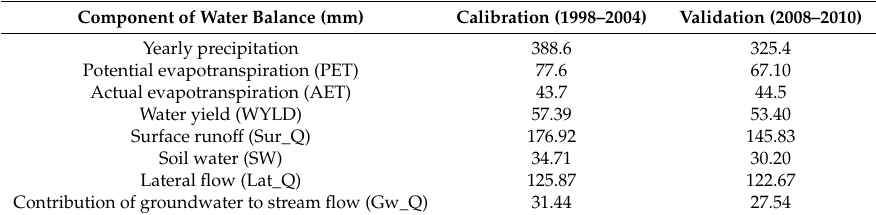
Table 5. Simulated daily average water balance components and their values.